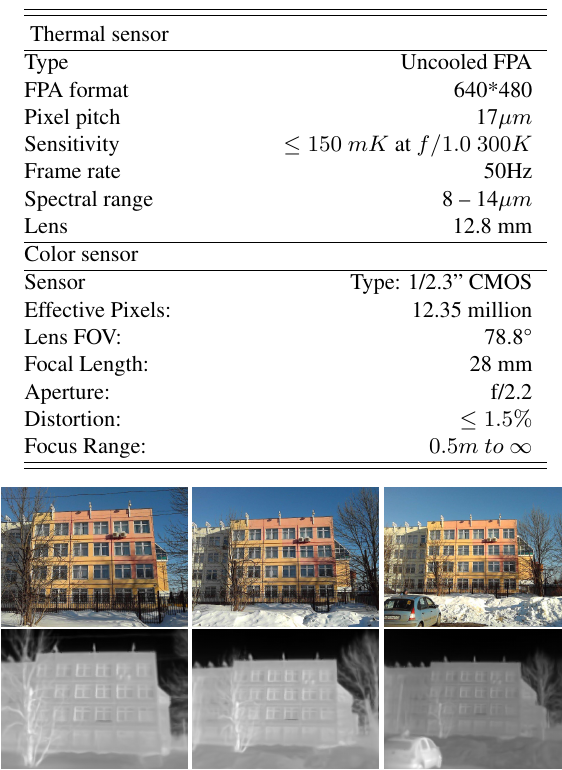
Figure 5. Testfield used for on-site camera